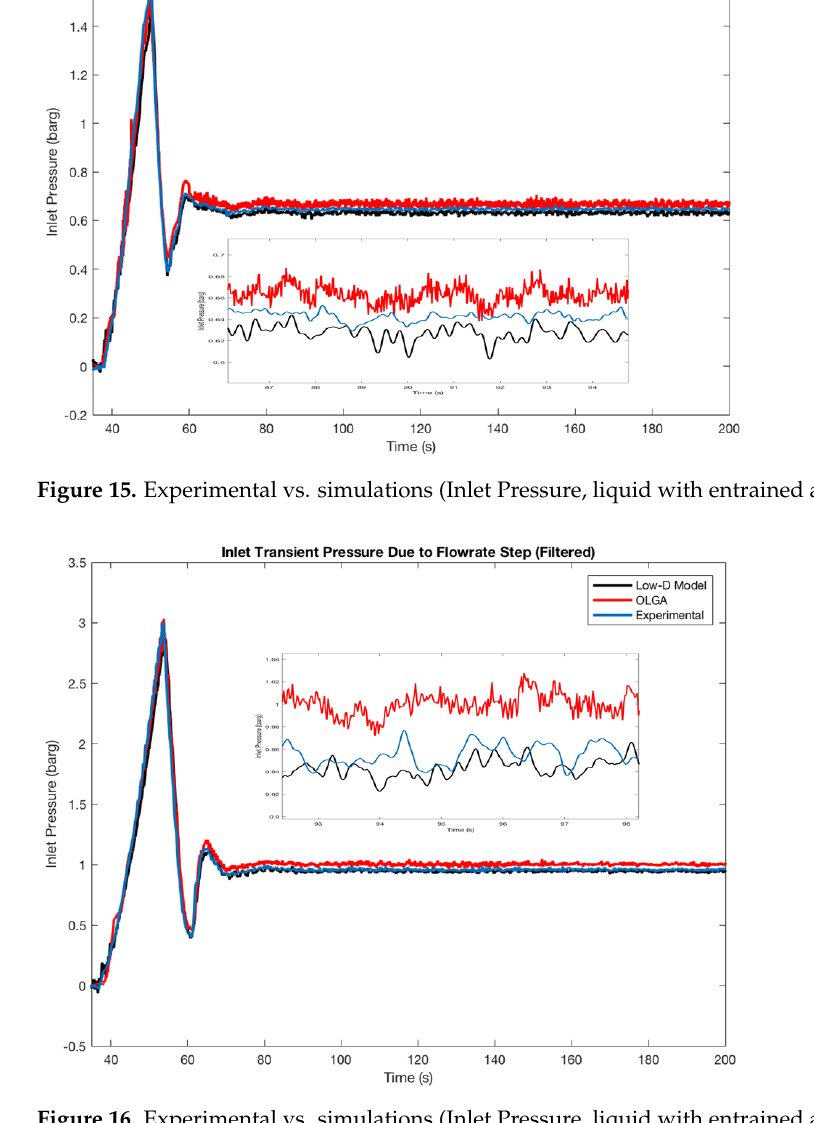
Figure 16. Experimental vs. simulations (Inlet Pressure, liquid with entrained air/case 3).